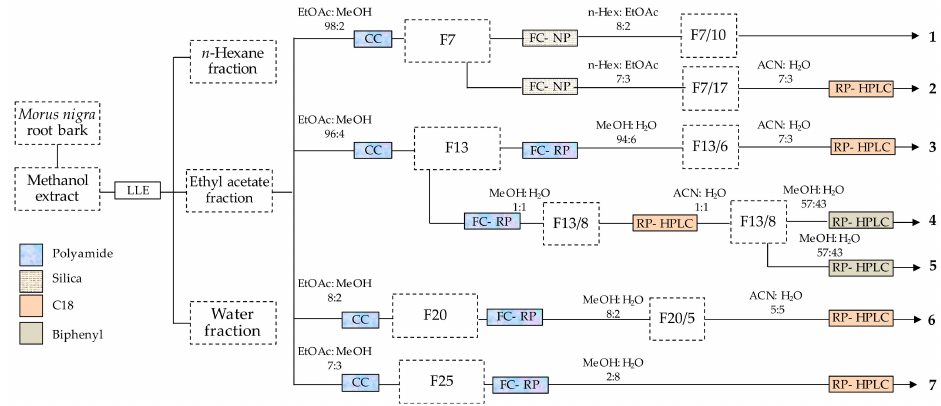
Figure 1. Procedure of isolating phenolic compounds from the root bark of Morus nigra . F numbers represent the corresponding fractions as detailed in the Materials and Methods, Section 3.3. LLE: liquid-liquid extraction), CC: column chromatography, FC-NP: flash chromatography on normal phase, FC-NP (flash chromatography on reverse phase, RP-HPLC: reverse-phase